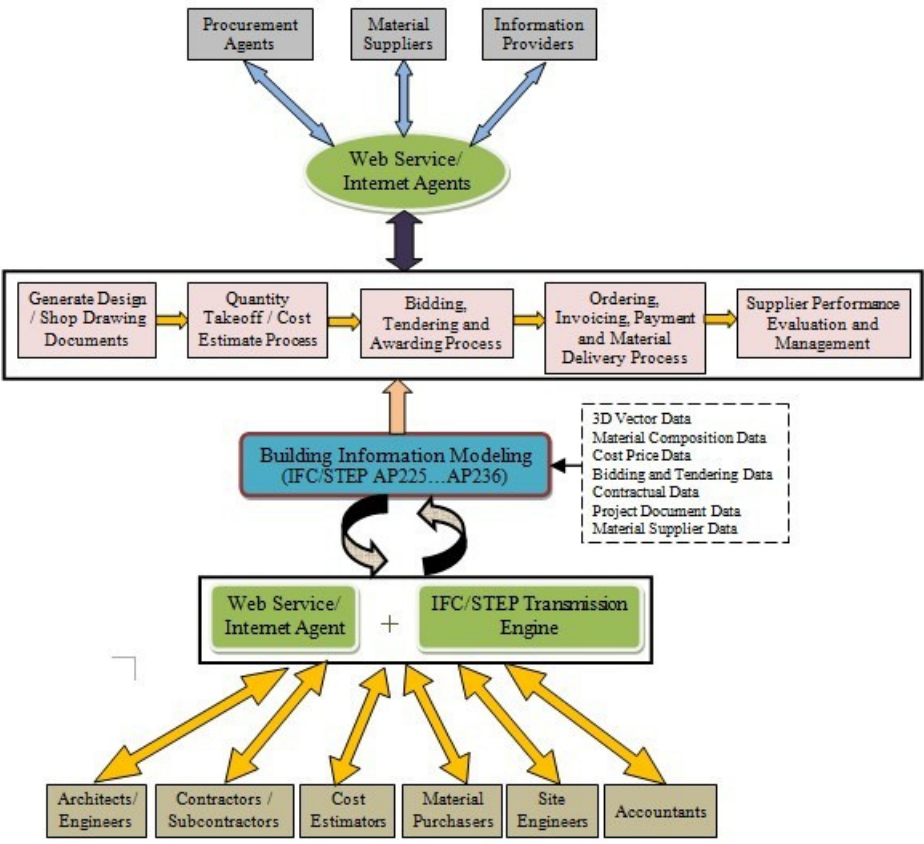
Fig. 5. Framework of BIM integrated with e-commerce